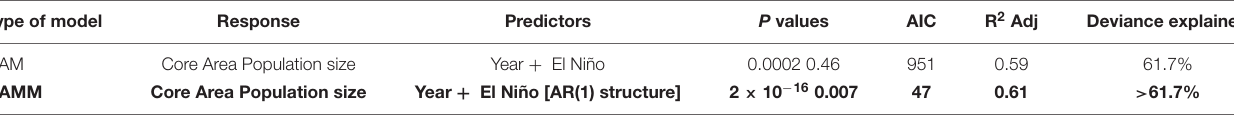
TABLE 2 | Comparison of Gam and GAMM models for core area (California) population size.